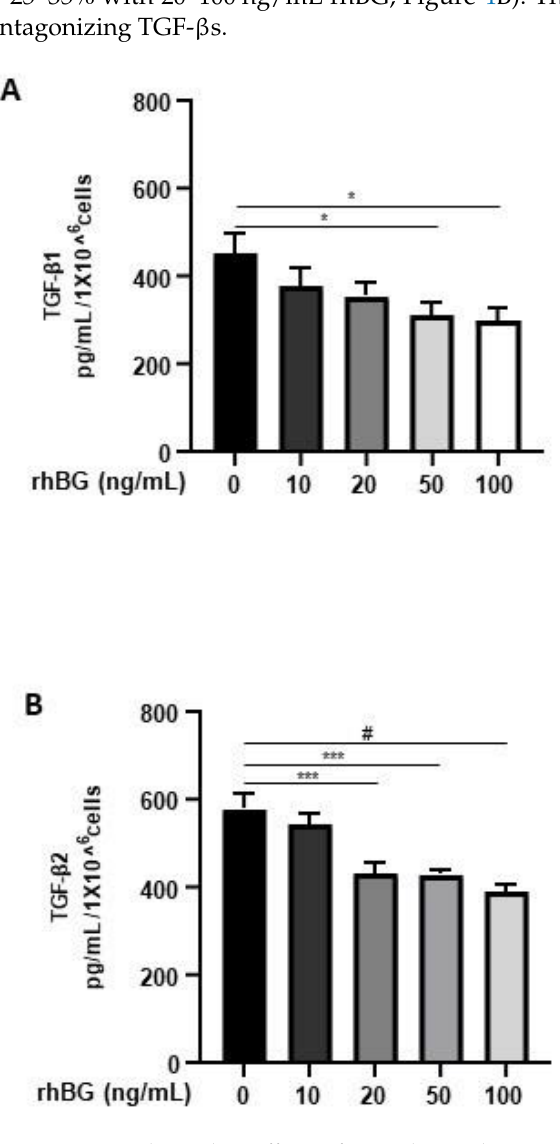
Figure 4. Dose-dependent effects of recombinant human BG on TGF- β 1 and TGF- β 2 secretion. Ep- ithelial 12Z cells were treated with increasing concentrations of recombinant human betaglycan (rhBG (10–100 ng/mL)) for 48 h, and supernatants were analyzed by TGF- β 1 ( A ) and TGF- β 2 ( B ) ELISAs. rhBG treatment significantly decreased TGF- β 1 and TGF- β 2 levels in a concentration-dependent manner. Each bar represents the mean ± SEM of three independent experiments performed in duplicate. * p ≤ 0.05; *** p < 0.001; # p < 0.0001; rhBG, recombinant human